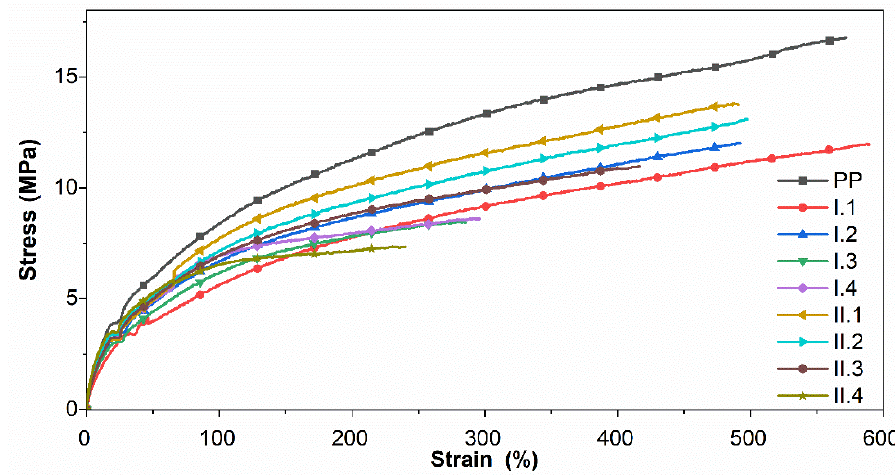
Figure 9. Stress-strain curves of PVC compound and PVC composites.